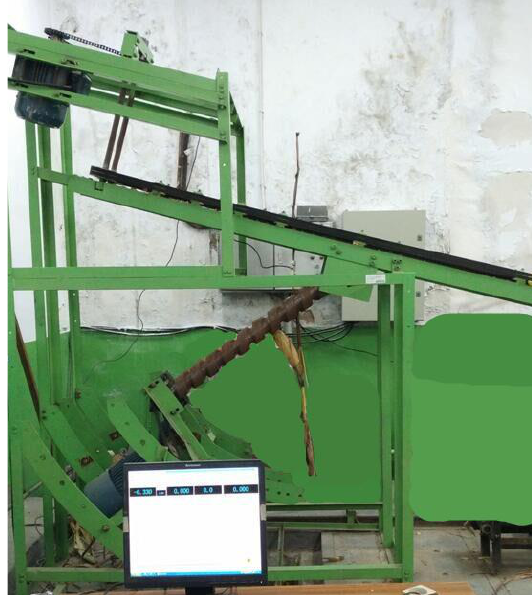
Figure 10. Experiment test on ear picking.